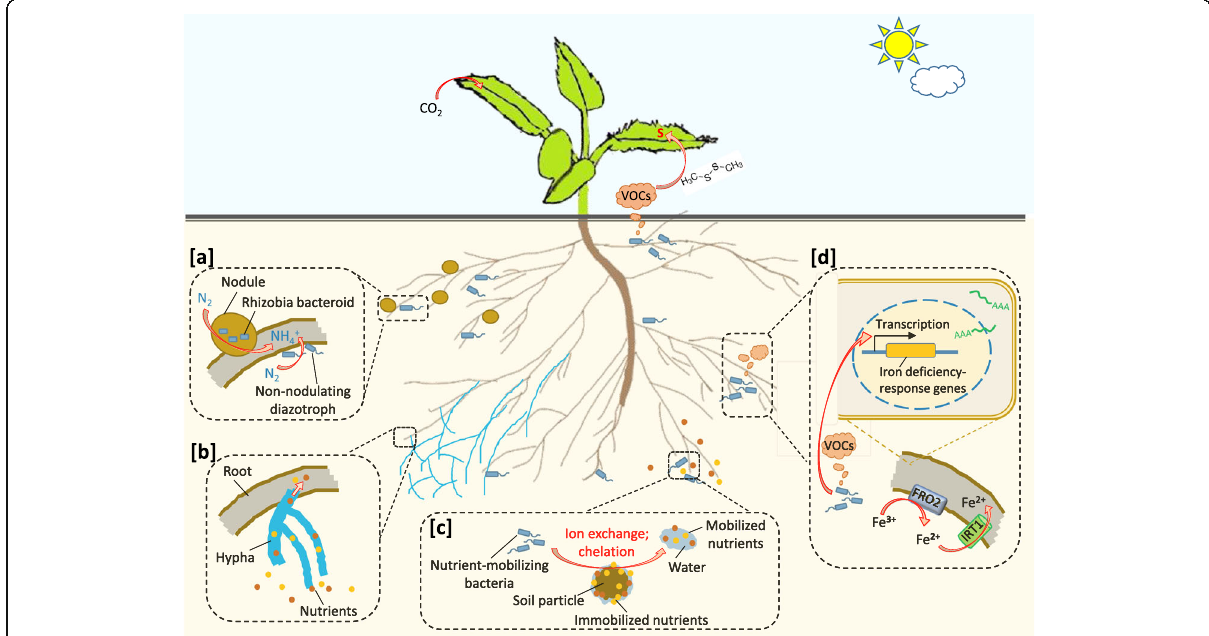
Fig. 1 Microbe-enhanced plant acquisition of macronutrients and micronutrients. Beneficial microbes enhance plant nutrient acquisition via multiple mechanisms, including but not limited to [ a ] N 2 fixation by rhizobia in nodules or by non-nodulating diazotrophs; [ b ] Nutrient uptake and delivery through mycorrhizal mycelia that reaches additional soil beyond the root; [ c ] Mobilization of soil-fixed nutrients through ion exchange or chelation by bacterial or fungal secretions, such as organic acids and siderophores; [ d ] Microbe-induced transcriptional regulation of plant genes involved in nutrient uptake, such as Arabidopsis Fe deficiency responses that are induced by bacteria volatile organic compounds (VOCs). Microbes may also enhance plant S nutrition via certain S-containing VOCs, such as dimethyl disulfite, which can be assimilated by the aerial portion of